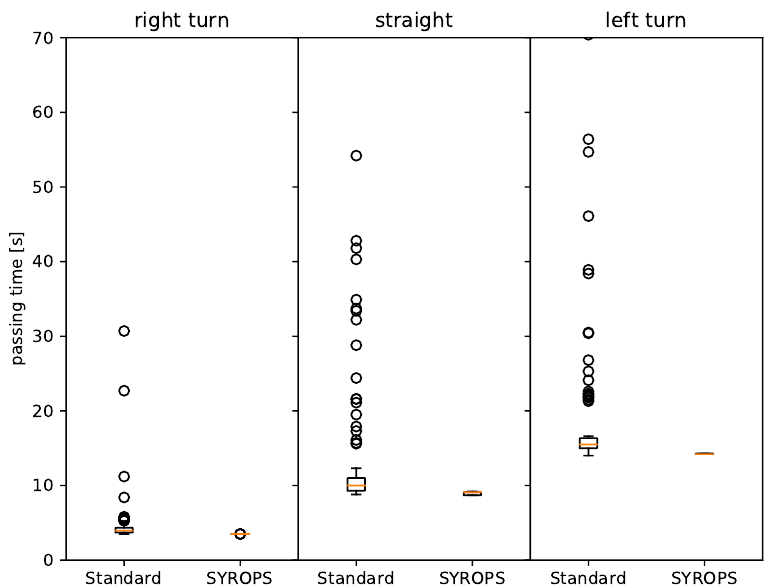
Figure 16. Roundabout delay per direction of travel for a roundabout radius of 35 m.